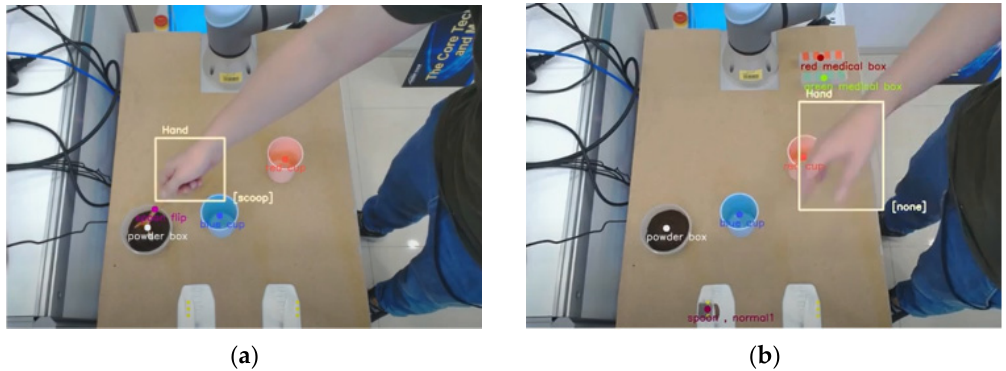
Figure 9. Experimental results of spatial-temporal action detection. The hand position is indicated by a yellow box and the action class is shown at the bottom left of the box. ( a ) example of detecting action “scoop”. ( b ) example of detecting nothing ‘none’.